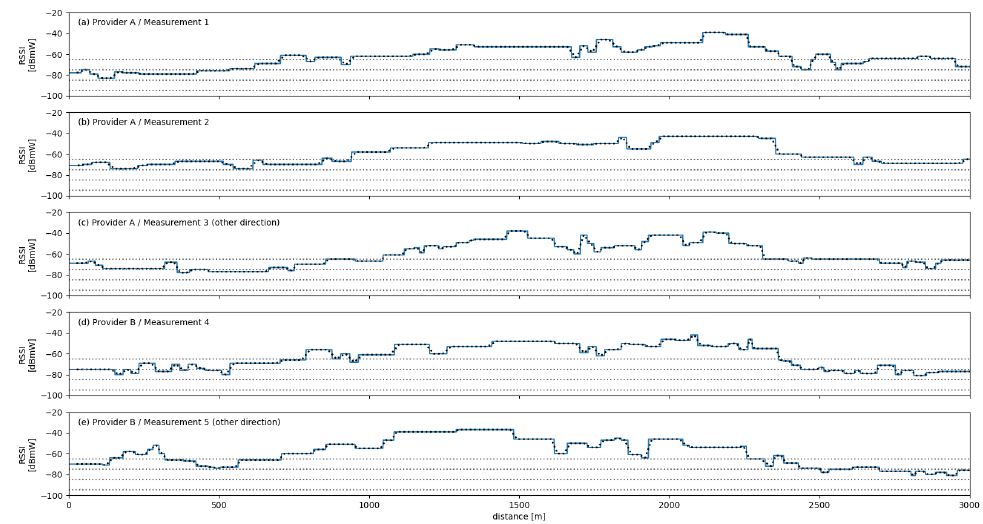
Figure 9. RSSI as a function of distance (solid lines: raw data; dots: resampled, interpolated data). Gray, dotted horizontal lines indicate ranges according to Table 4.